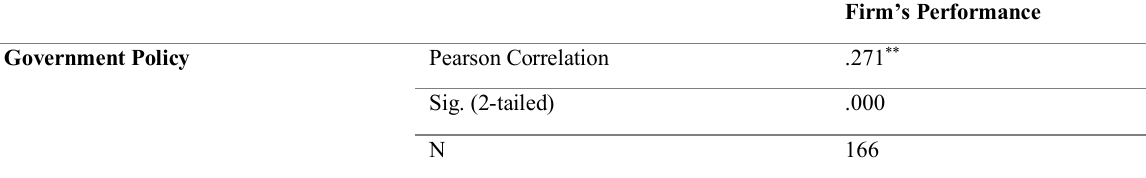
Table 3 : Correlation between government policy index and firm’s